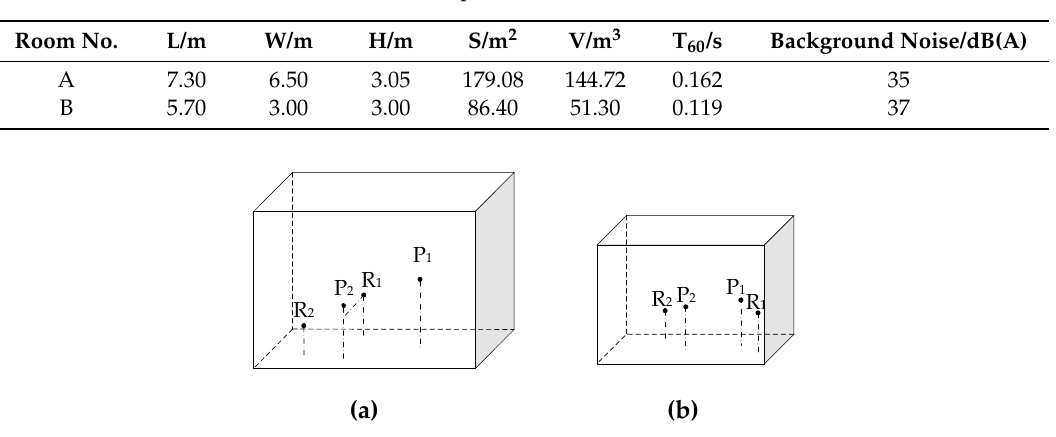
Figure 1. Binaural signal collection scene in real rooms. ( a ) Room A ( b ) Room B. Table 2. The parameters of real rooms.